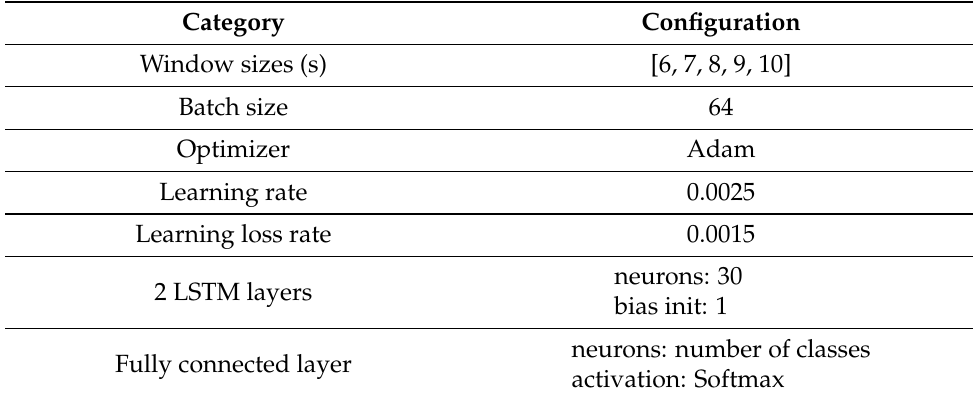
Table A6. WISDM DTE LSTM model configuration.